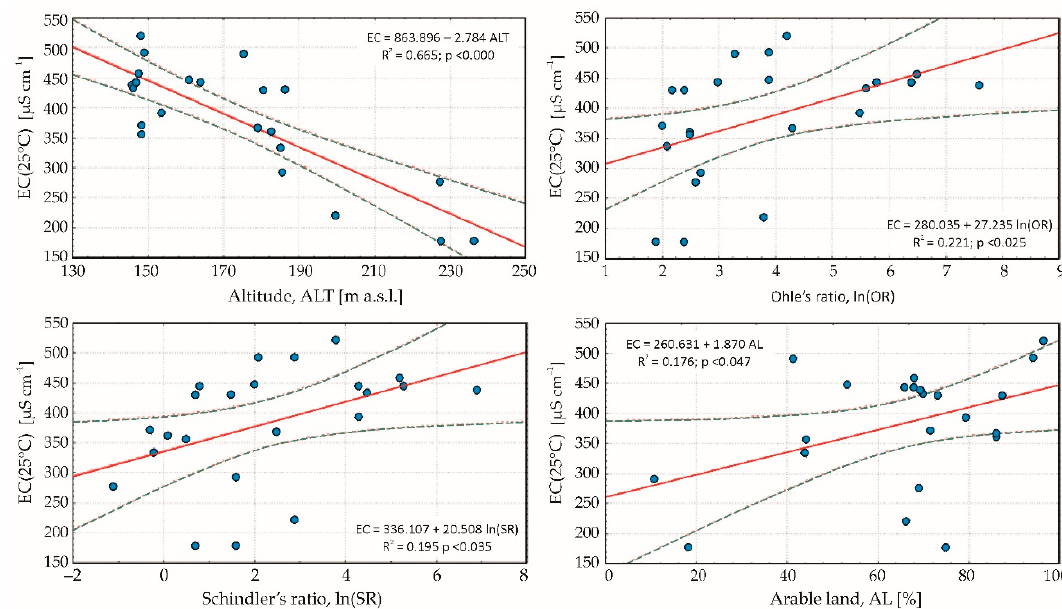
Figure 2. Scatter plots with 95% confidence intervals representing the statistical relationships between the conductivity of surface waters and the selected catchment characteristics based on data from the 23 SLP 23 SLP lakes.